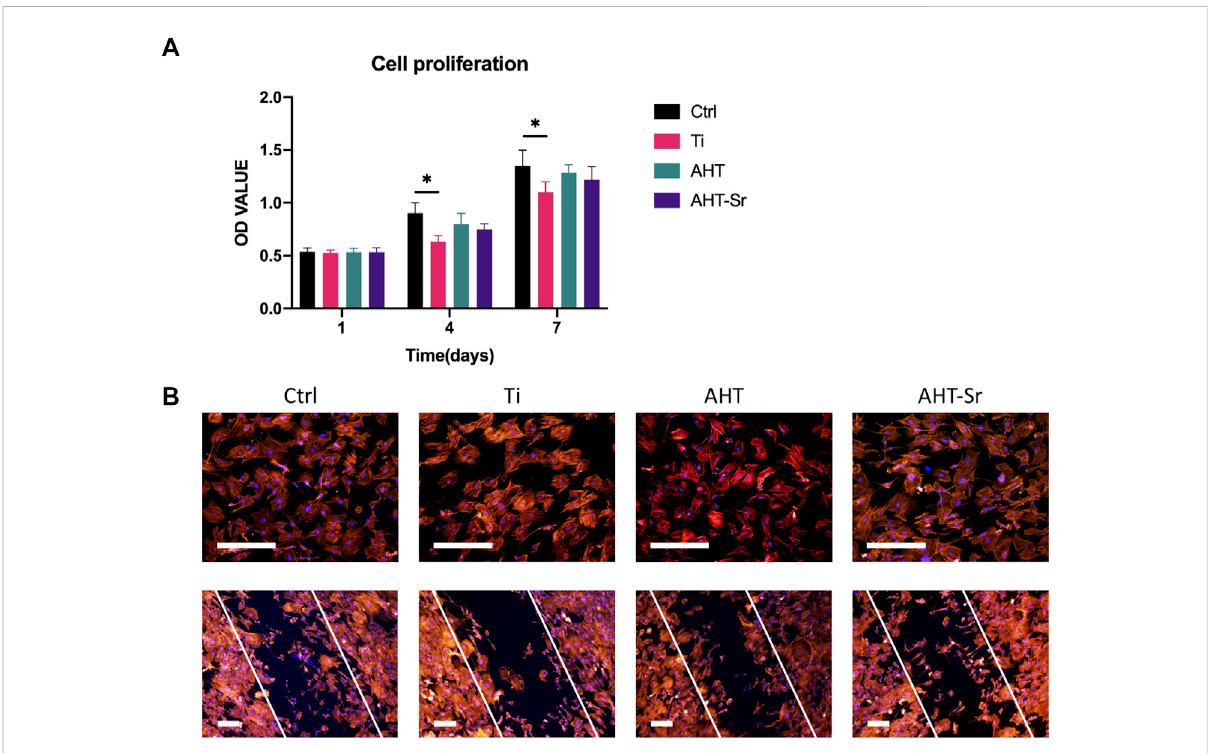
FIGURE 4 Biocompatibility studies on Ti disks. (A) Proliferation of H-BMSCs grown on Ti surfaces and OVX-BMSCs grown on different Ti disk surfaces. (B) F-actin immunostaining images of H-BMSCs and OVX-BMSCs grown on Ti, AHT, and AHT-Sr. Representative images of three separate experiments. Scale bars: 100 μ m. Error bars indicate the SD of three separate